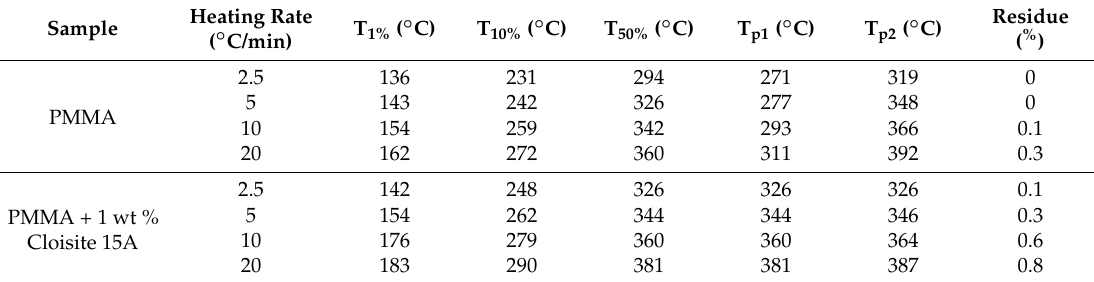
Figure 3. The heating rate efficacy on the TGA scans ( a ) and DTGA curves ( b ) of PMMA + 1 wt % Cloisite 15A. Table 1. Temperatures where 1% (T 1% ), 10% (T 10% ) and 50% (T 50% ) thermal degradation occurs, as well as of the first and second degradation peak and residue for each sample studied at different heating rates.